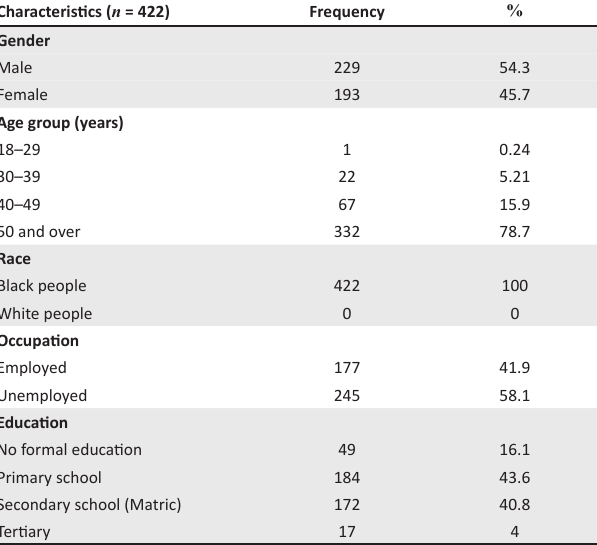
TABLE 1: Demographic characteristics of study